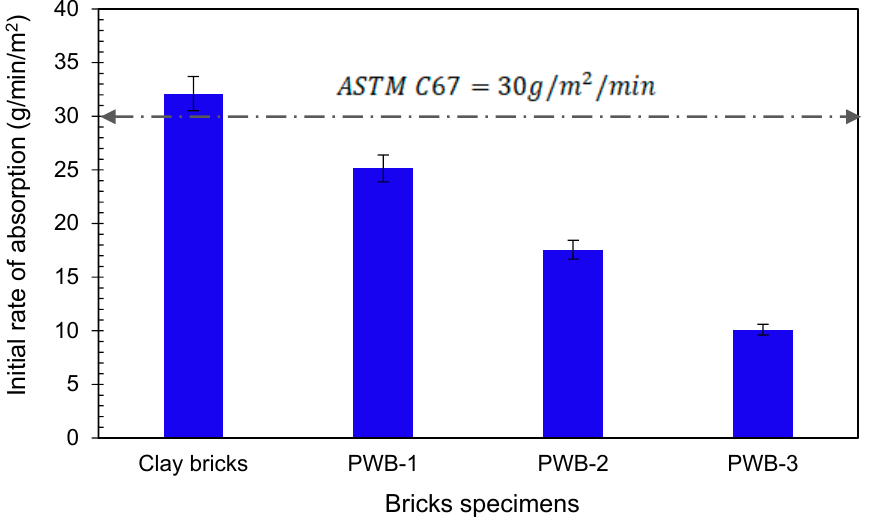
Figure 10. Initial rate of absorption for the produced brick specimens.